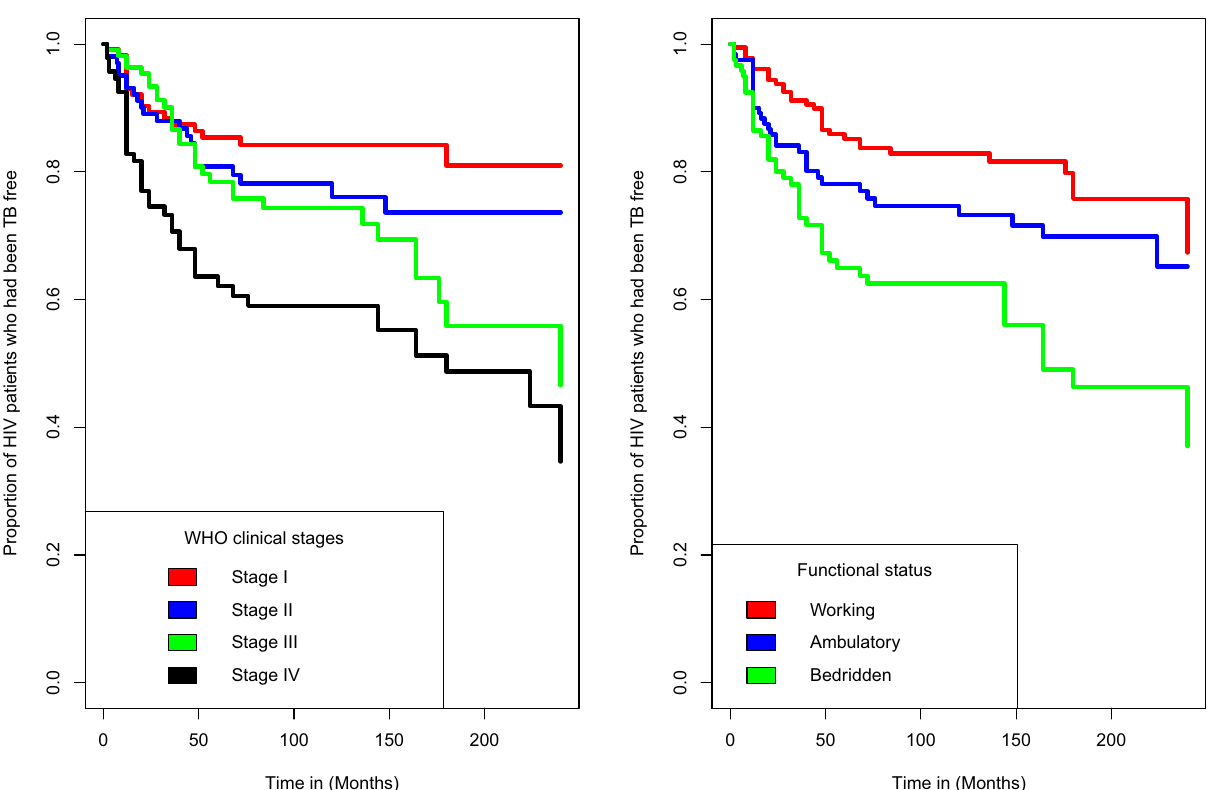
Figure 4. Kaplan-Meier survival curves for TB free co-infection free survival time of patients by disease stages and functional status of